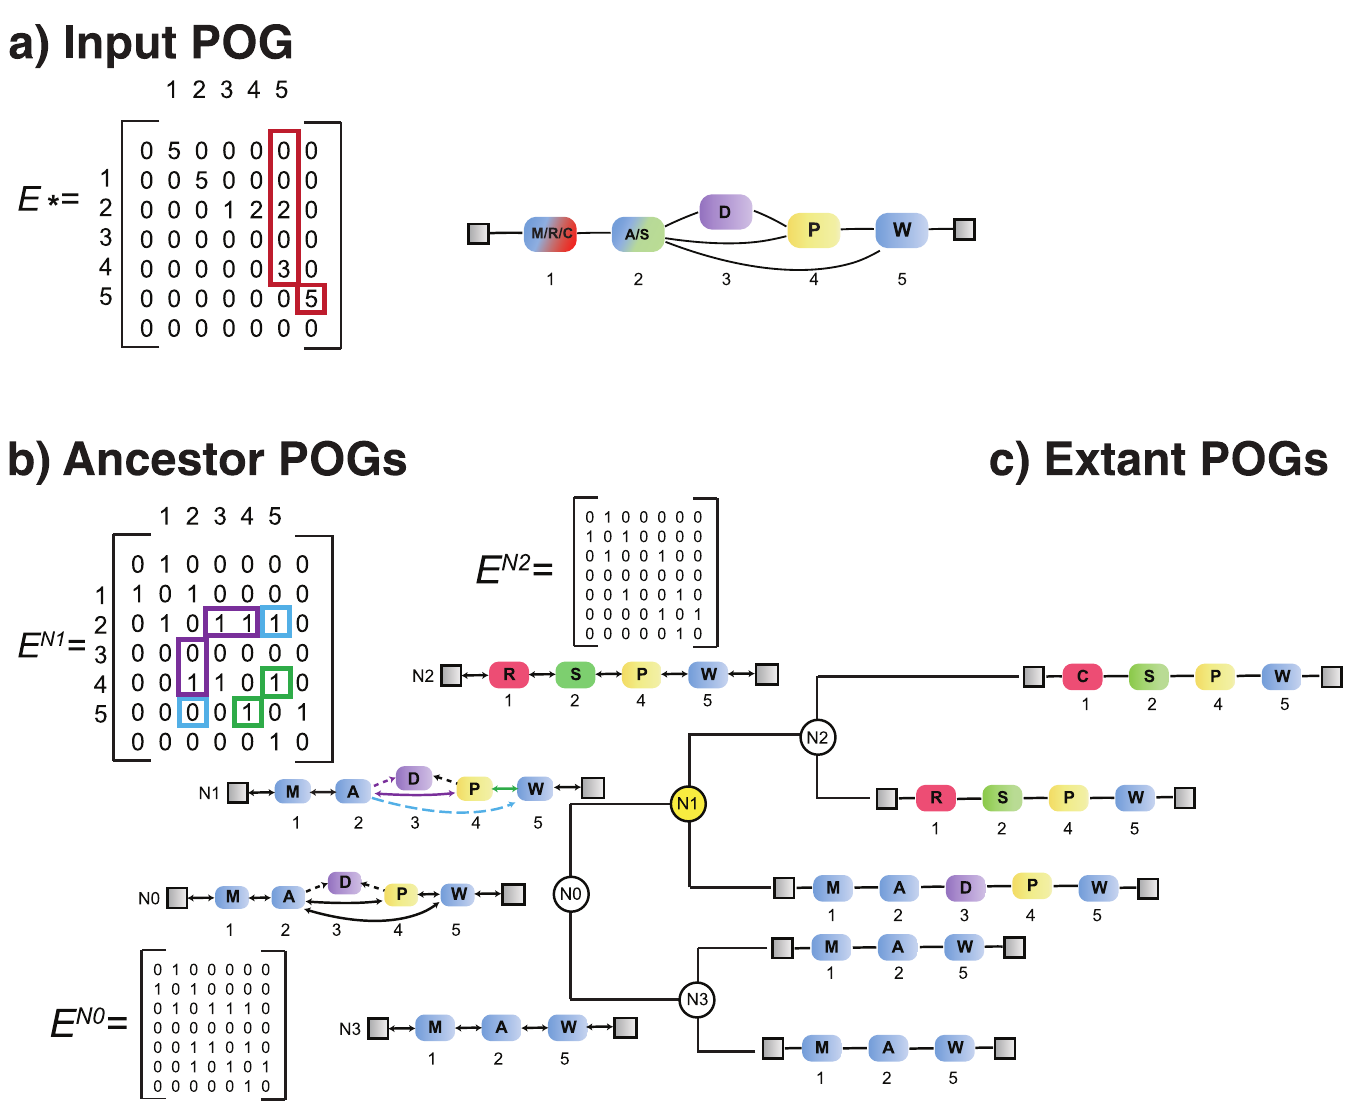
Fig 6. A tree with five extant sequences and ancestors with bi-directional and uni-directional support for different edges shown. A , Input POG and the matrix E � (recovering all edges under consideration for ancestors). Red squares refer to all edges involving position 5 (occupied by W in all sequences). Non-zero entries in the red squares identify indices for 2 and 4, as well as the end terminus. B , Ancestor POGs (labelled N0-N3) are shown at branch points as inferred by bi-directional edge parsimony. Solid arrows indicate bi-directional support; dashed arrows indicate uni-directional support. For uni-directional edges, the direction of support is shown by the direction of the arrow. The N1 ancestor is annotated to illustrate the relationship between indices in an ancestral matrix and the edges in the resulting ancestor POGs. The ( a , b ) and ( b , a ) indices are highlighted for select positions—for example, (4,5) and (5,4) are the forwards support from index 4—5 and backwards support from index 5—4 (green boxes and green edge in N1) showing that the edge from 4—5 is supported in both directions. The edge from 2—5 is supported going forward but not backward (blue boxes and blue edge in N1). Other edges forward from index 2 are maximally parsimonious in the forward direction at N1, such as 2—3 and 2— 4, but only the support for 4 is reciprocated (purple boxes and purple edges in N1) recovering a “preferred” path from 2 to 4 to 5 in N1. C , Extant POGs, with position